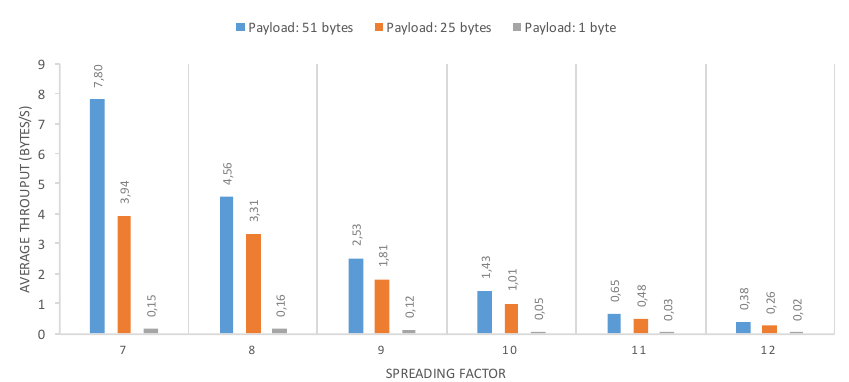
Figure 9. Maximum throughput attained by a single device using